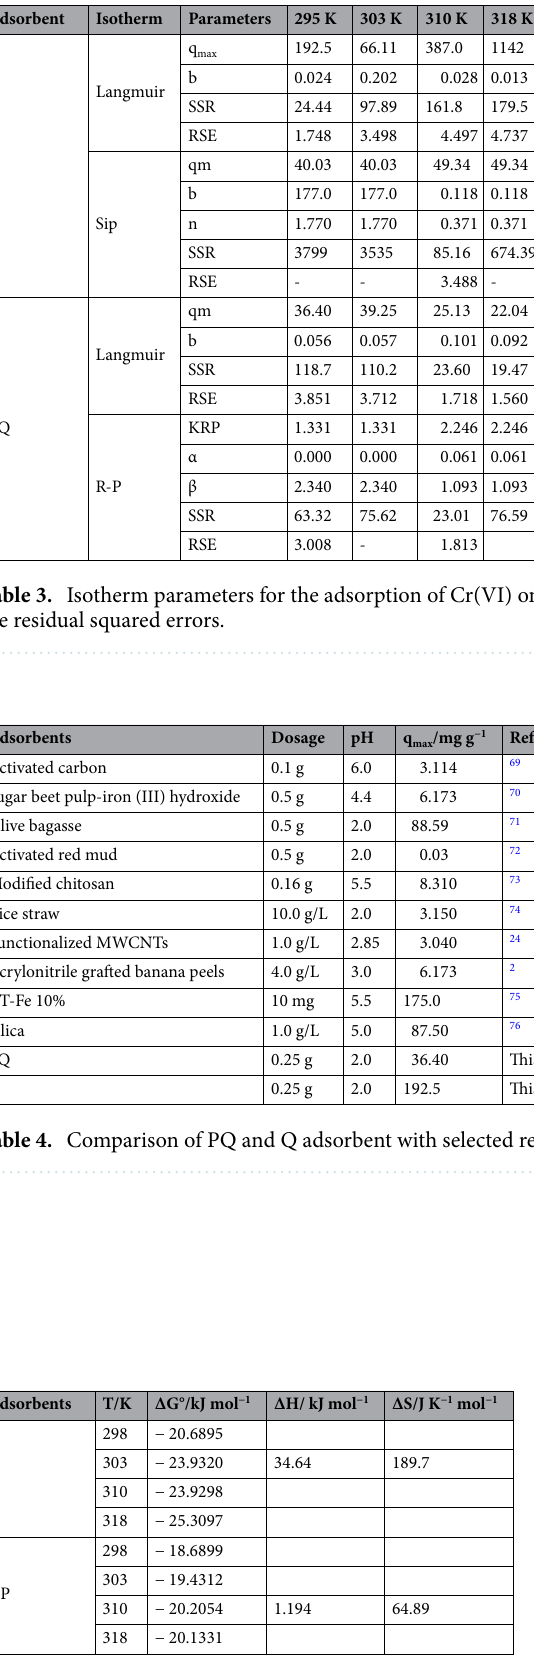
Table 5. Thermodynamic parameters for the adsorption of Cr(VI) onto PQ and Q.